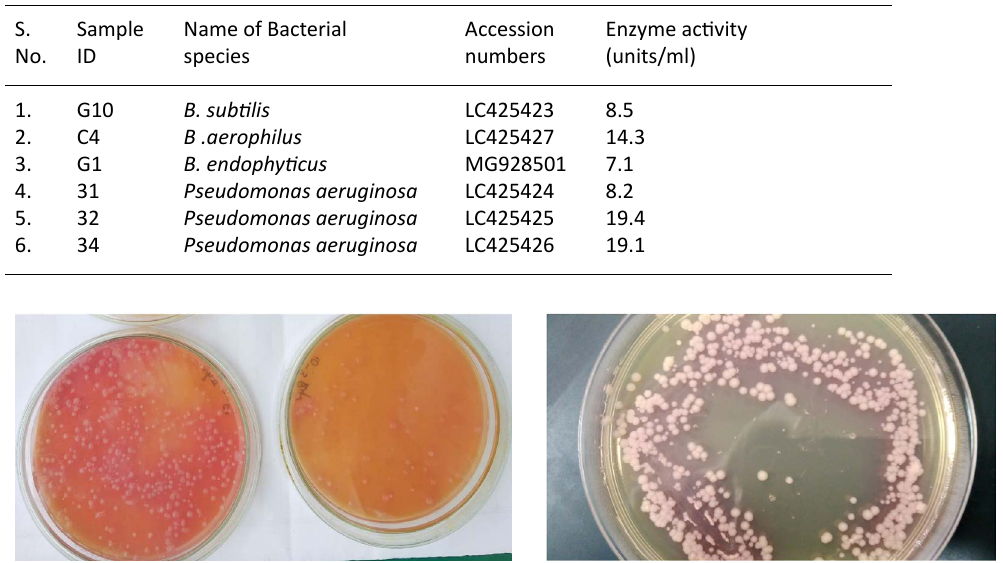
Table 2. Enzyme activity of the isolates producing L asparaginase (IU/ml) S. Sample Name of Bacterial Accession Enzyme activity